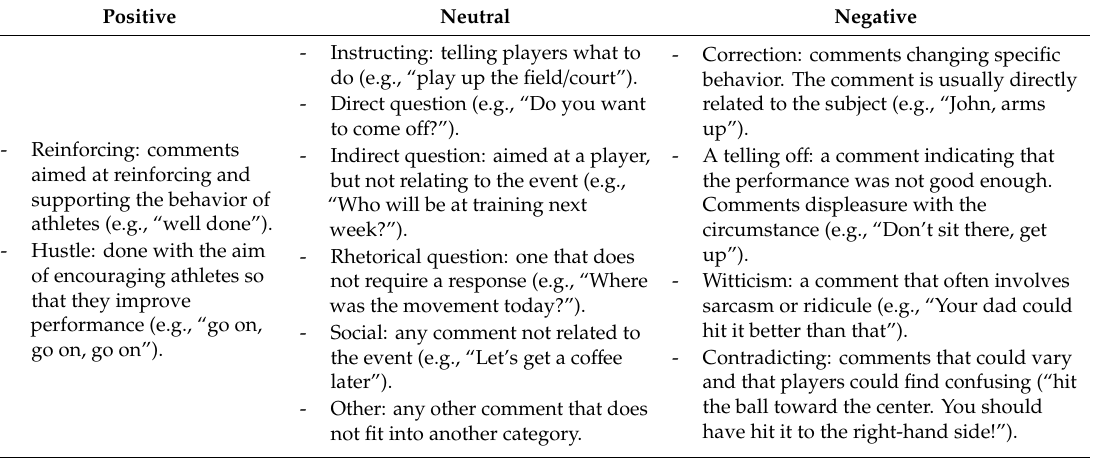
Table 1. Categories of the kind of comments made by family spectators